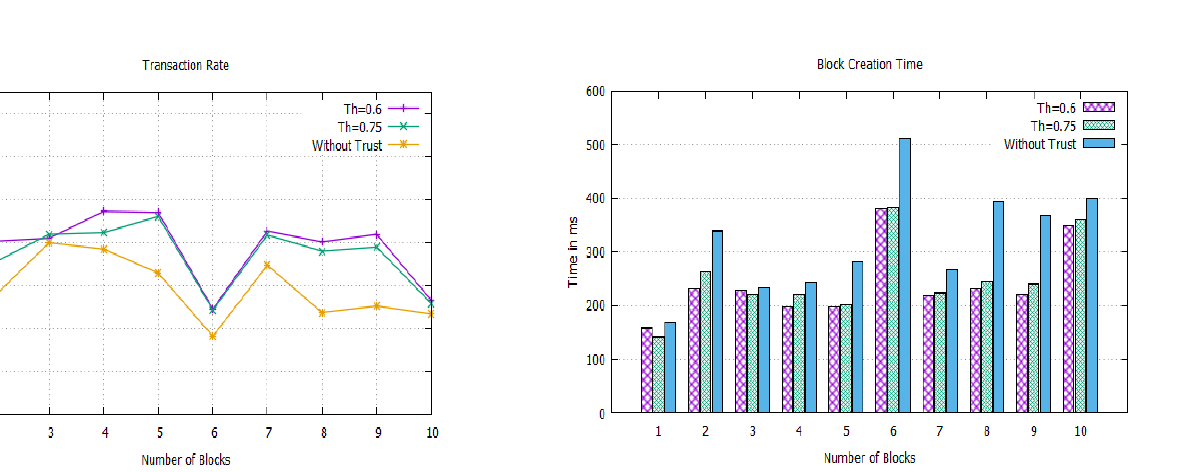
Figure 4.3 Block Processing